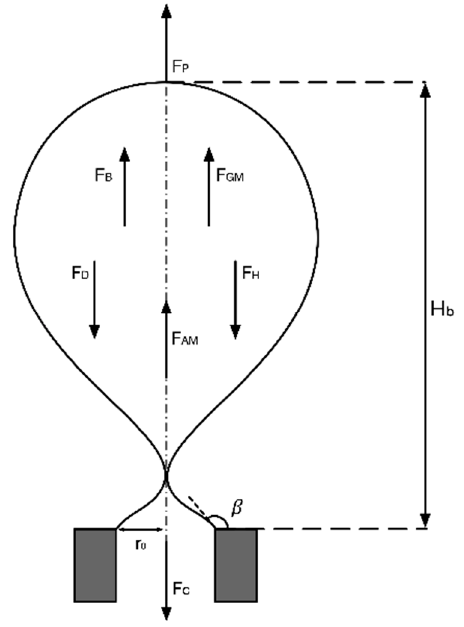
Figure 12. Schematic diagram of force balance.